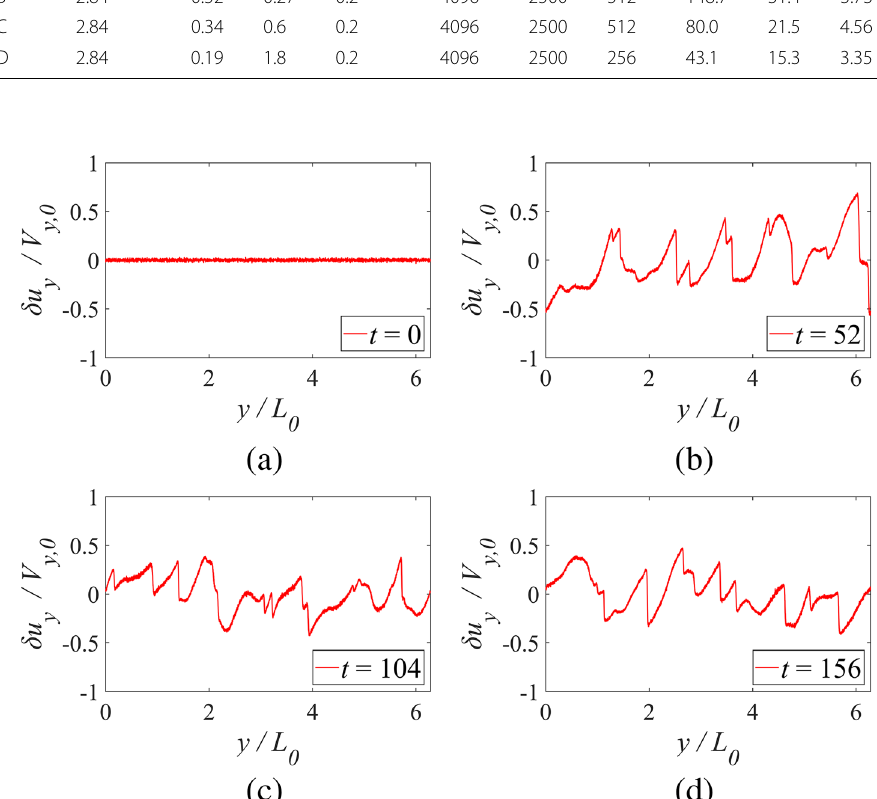
Fig. 2 Snapshots of velocity fluctuations for the Case